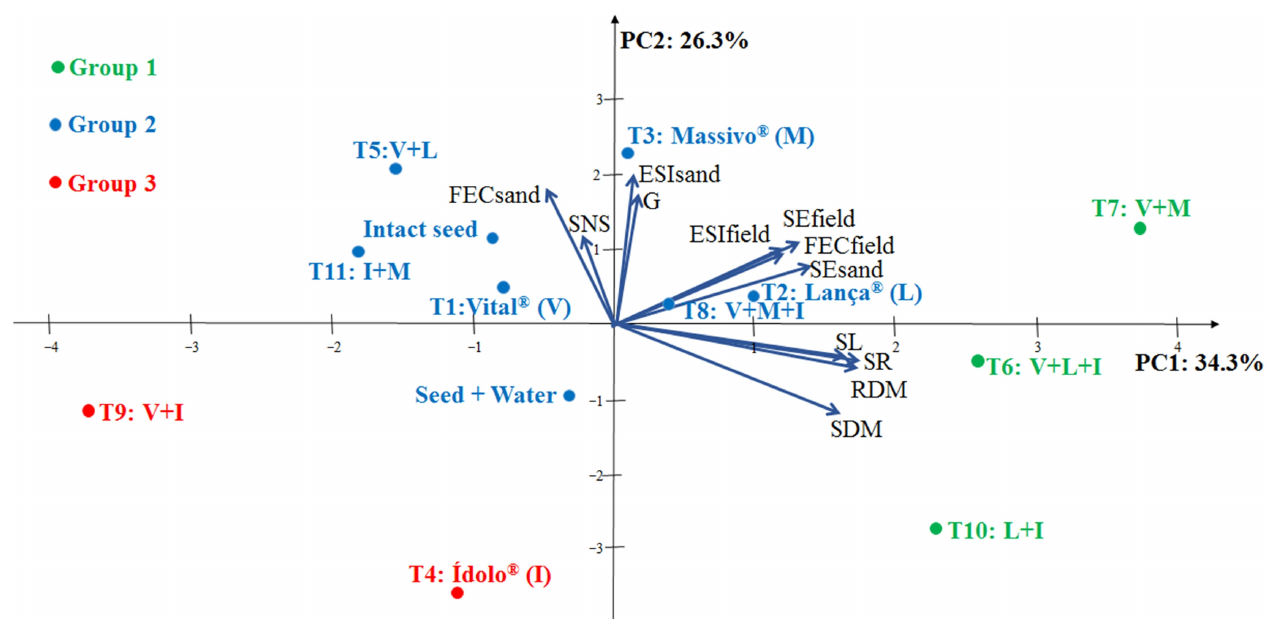
Figure 2. Biplot with the circle of eigenvectors obtained by the analysis of two principal components (PC1 and PC2) established according to germination (G), strong normal seedling (SNS), seedling emergence in sand (SEsand), emergence speed index in sand (ESIsand), first emergence count in sand (FECsand), seedling emergence in the field (SEfield), emergence speed index in the field (ESIfield), first emergence count in the field (FECfield), root length (RL), shoot length (SL), root dry matter (RDM), and shoot dry matter (SDM) of soybean NS7667 IPRO seedlings from different seed treatments. Jataí, GO, Brazil, 2022.